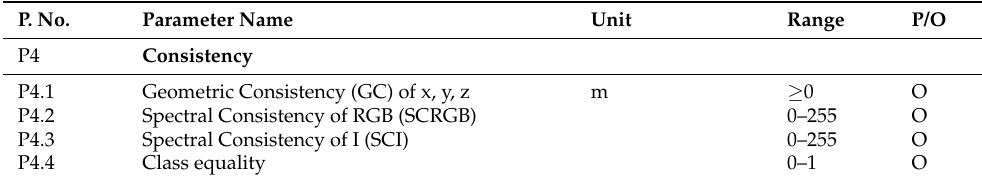
Table 8. Parameters for consistency.